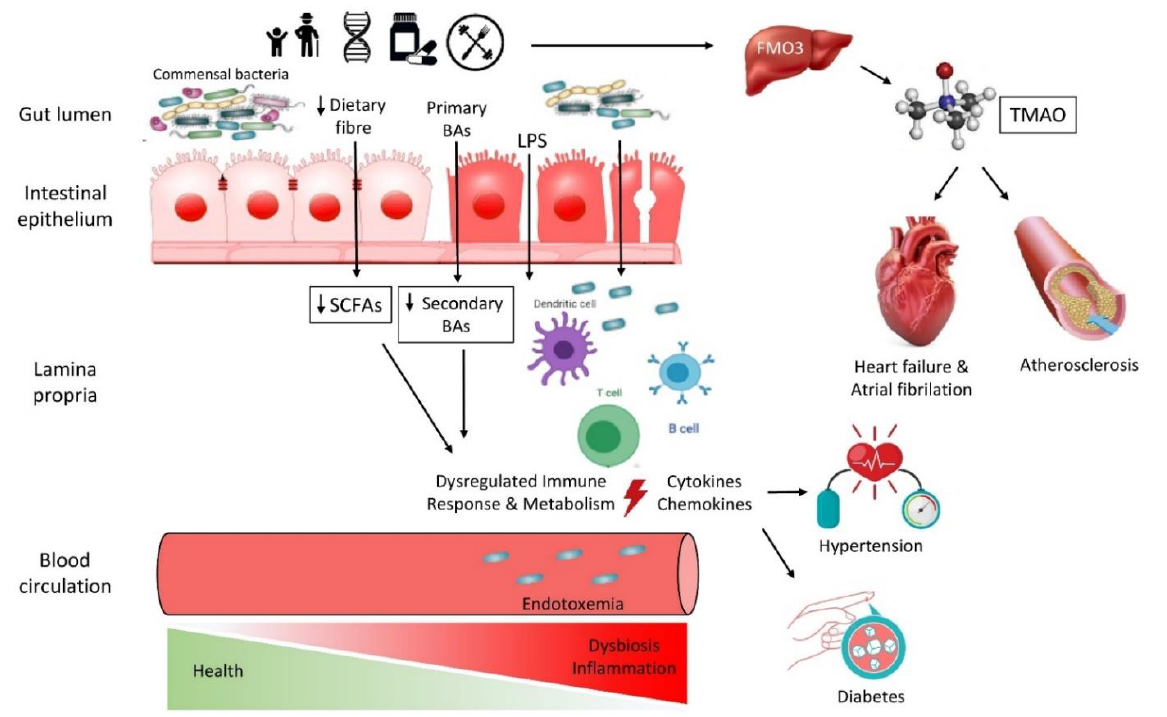
Figure 1. A simplified summary of the interconnections between the gut microbiota and traditional and non-traditional risk factors. TMAO: Trimethylamine-N-oxide, LPS: Lipopolysaccharides, FMO: Flavin-containing monooxygenase, BAs: Bile Acids, SCFAs: Short Chain Fatty Acids.